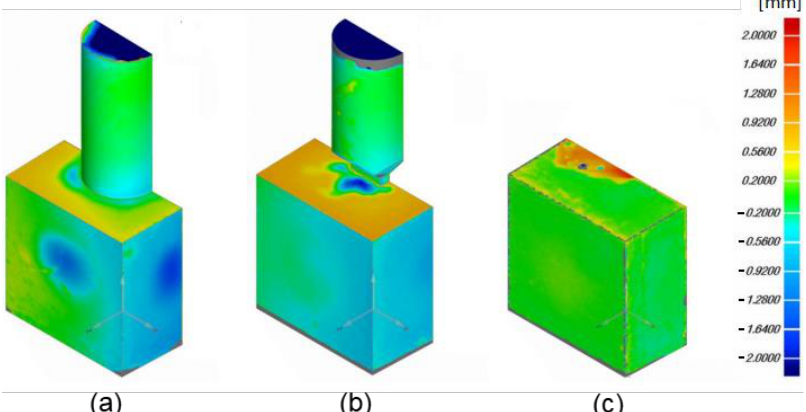
Figure 11. Scanning results of the prototypes poured at 1300 °C: ( a ) Prototype A2, obvious surface sink; ( b ) Prototype B2, surface sink around the riser neck; ( c ) Prototype C2, unevenness of the top surface.